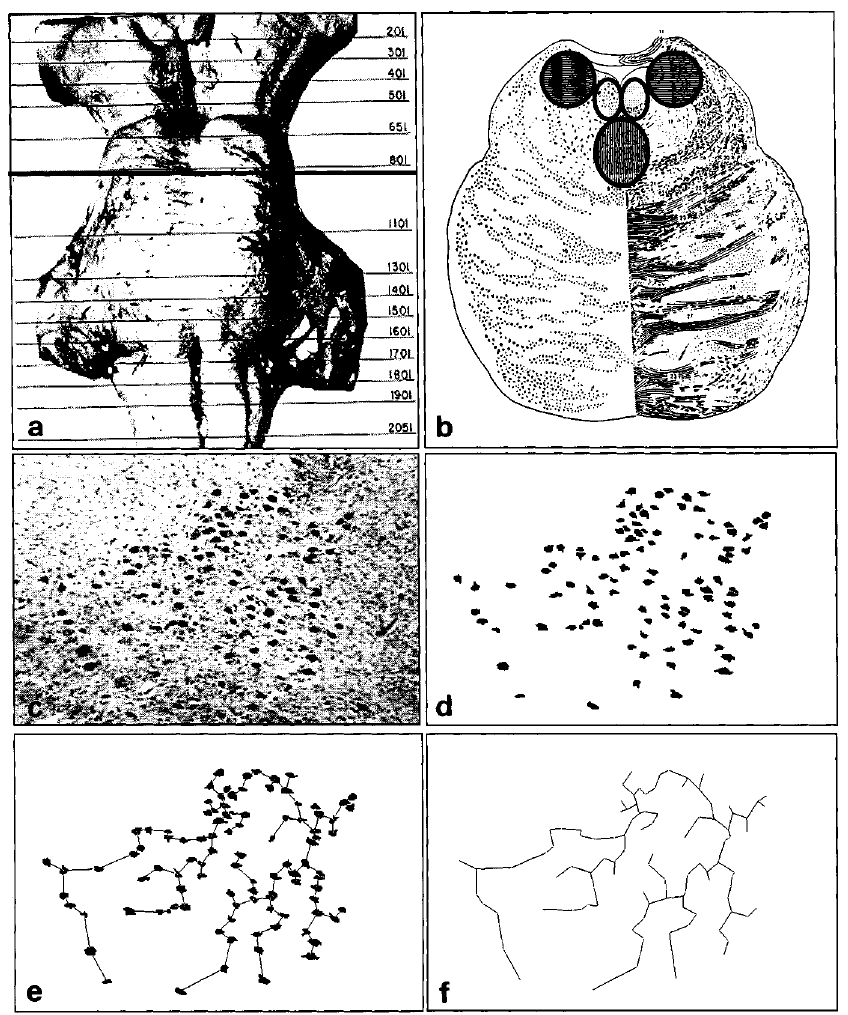
Fig. 1. (a, b) Lower brainstem with cross sectional level selected for the present evaluations ((a) from Olszewski and Baxter [77, p. 19]; (b) modified from Nieuwenhuys et al. [73, pp.